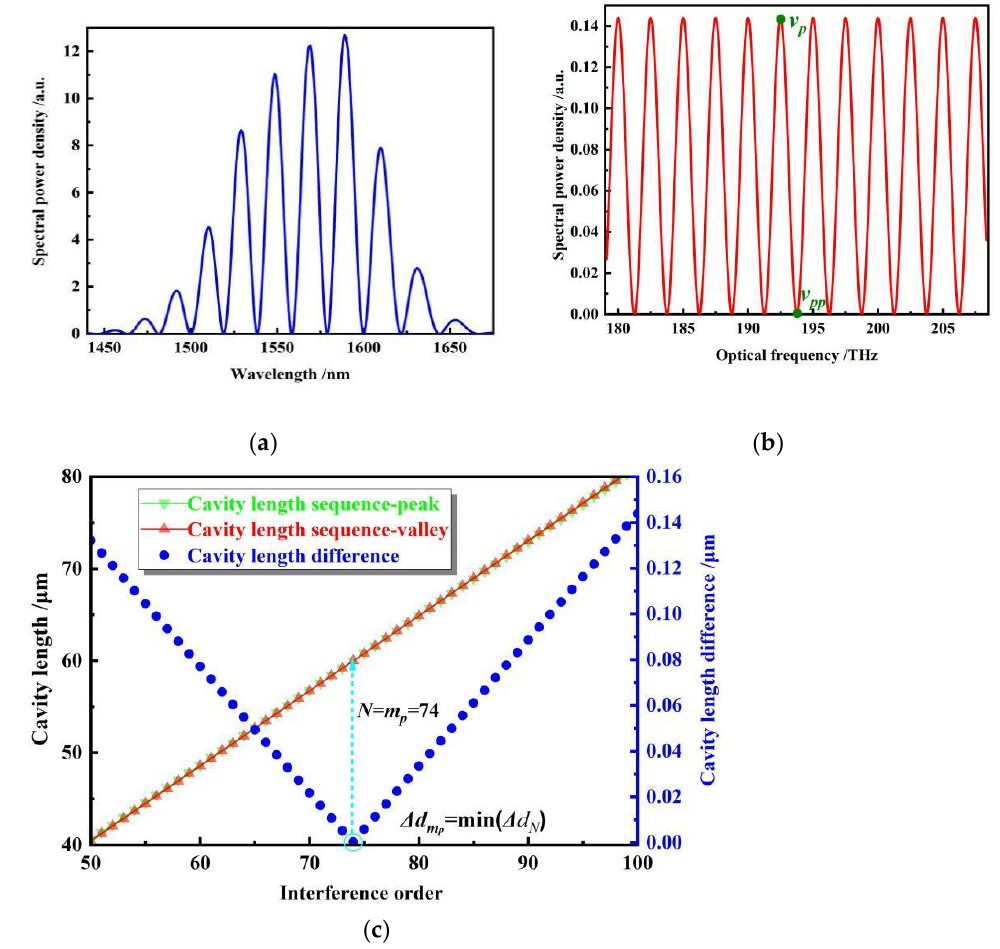
Figure 3. Simulating demodulation of a 60- μm fiber-optic FP sensor through the CLSM algorithm. ( a ) Reflection spectrum; ( b ) corrected reflection spectrum in the frequency domain; ( c ) generated cavity length sequences and their differences.